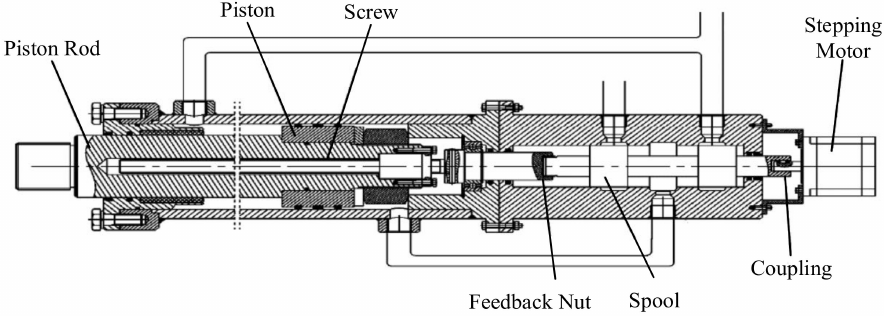
Figure 14. Stepping digital hydraulic cylinder.